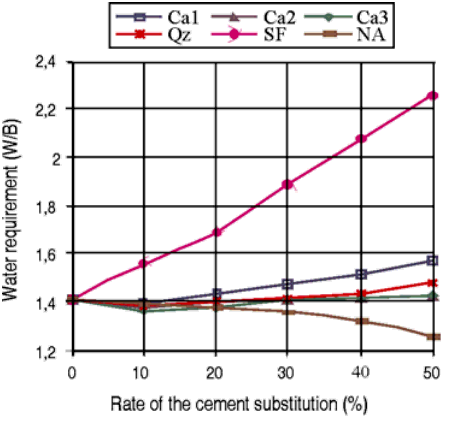
Fig 1. Effect of the cement substitution by mineral admix- tures on the water requirement of